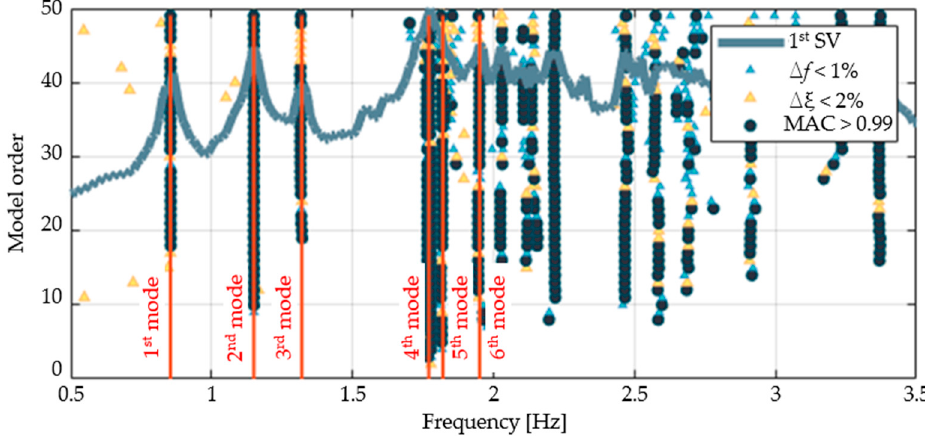
Figure 15. Example of stabilization diagram that was obtained for the identification procedure of the Dyn.1 test.